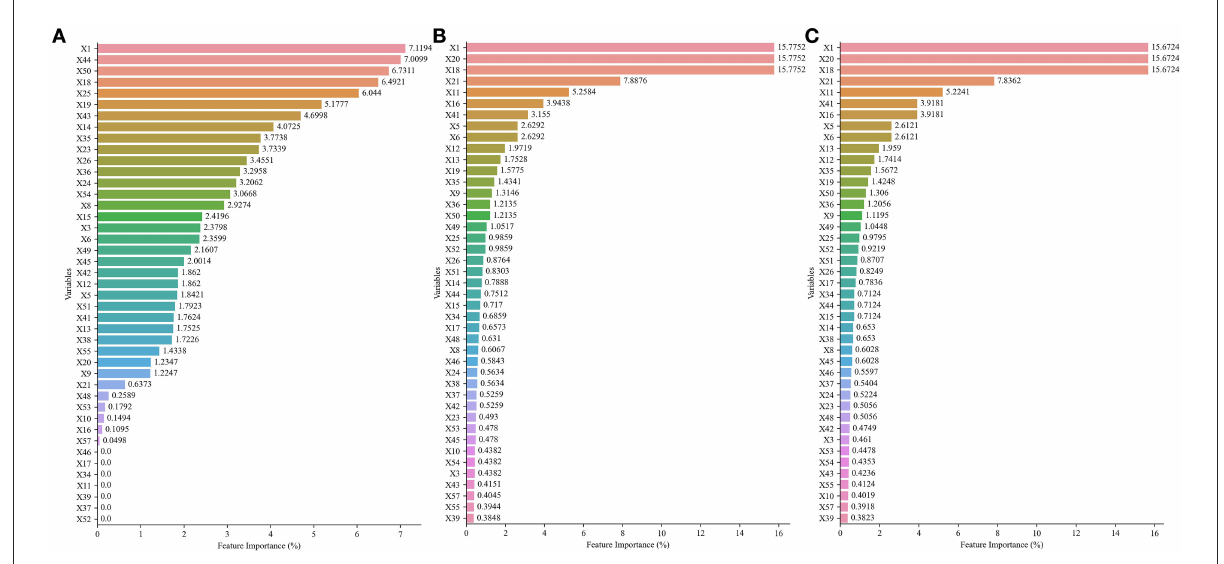
FIGURE3 The importance scores and ranking of each variable in No. 27 dataset, No. 44 dataset, and No. 59 dataset with different variable selection methods. (A) Details of No. 27 dataset. (B) Details of No. 44 dataset. (C) Details of No. 59